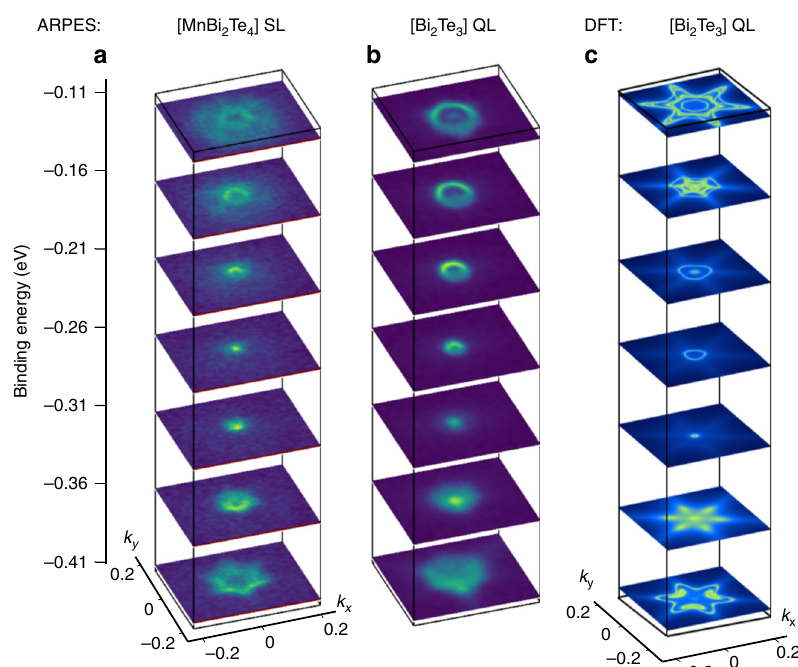
Fig. 5 Experimental and theoretical constant energy slices. a , b ARPES constant energy surfaces sliced at every 50 meV. c The same contours calculated by DFT for the [Bi 2 Te 3 ] QL termination. The six-fold symmetric snow fl ake-like surfaces are seen in all